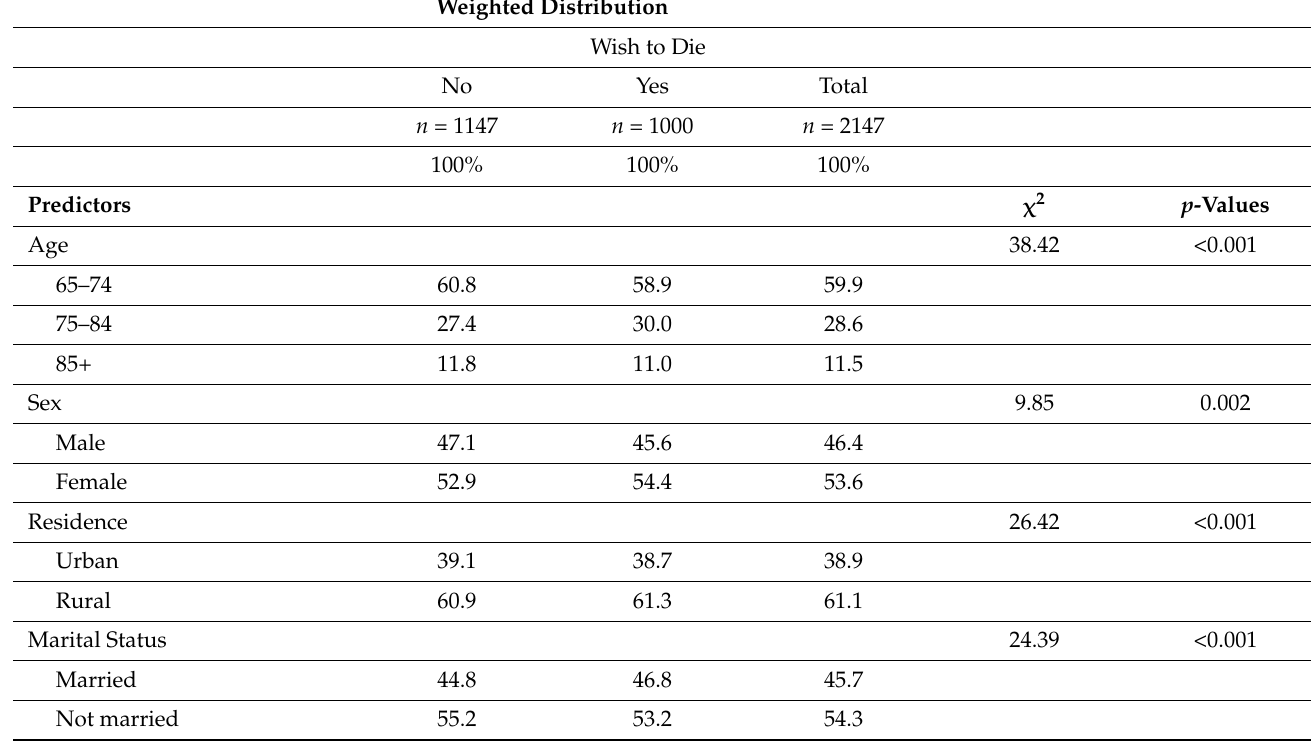
Table 1. Statistics on factors associated with the wish to die in